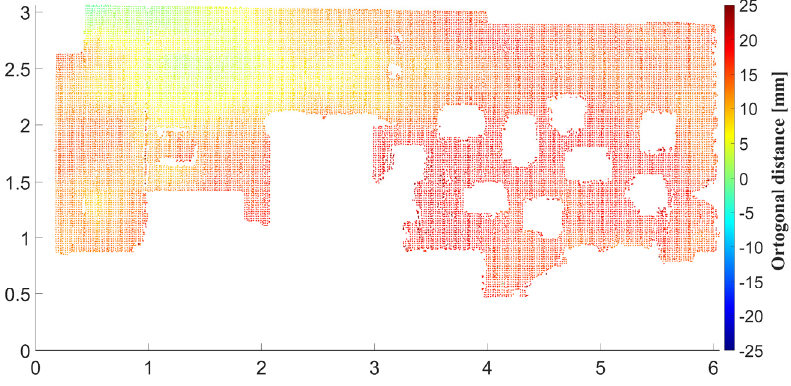
Figure 12. Deviation map—comparison of the IFC plane and the segmented point cloud. The second deviation map (generated for the same wall) quantifies the flatness of the wall (Figure 13). The flatness of the wall is calculated as the orthogonal distance of each point of the point cloud from the estimated regression plane using (12).